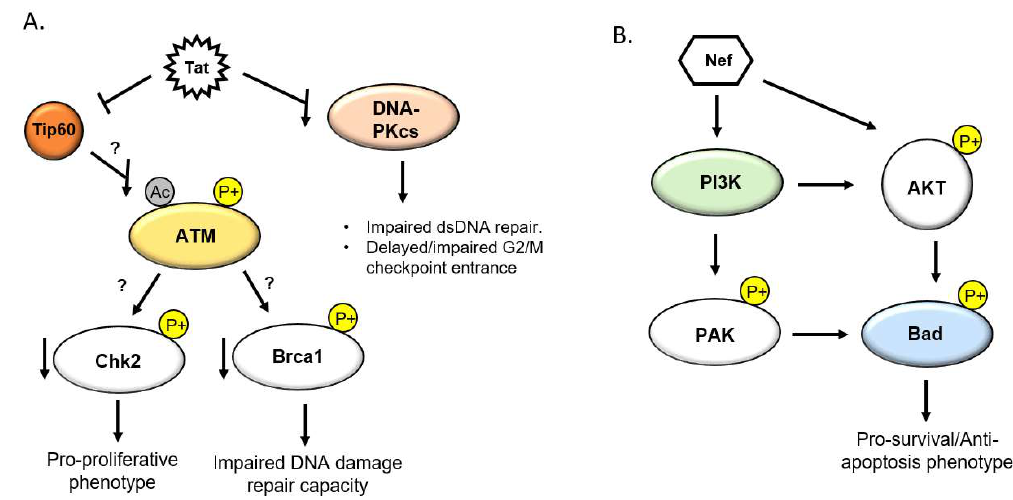
Figure 2. HIV factors Tat and Nef modulate the DNA Damage Response. ( A ) Tat is known to impair Tip60 activity, which in turn may attenuate ATM activation, resulting in impaired signaling to downstream e ff ector substrates. Tat results in depression od DNA-PKcs and results in impaired dsDNA repair capacity and impaired checkpoint entrance ability. ( B ) Nef induces a pro-survival phenotype through PI3K and AKT activation, resulting in excessive phosphorylation of Bad and depression of apoptosis signaling.